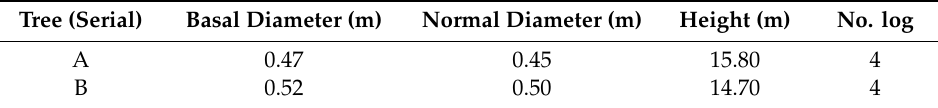
Table 1. Basic characteristics of the chosen trees and samples of series. Tree (Serial)